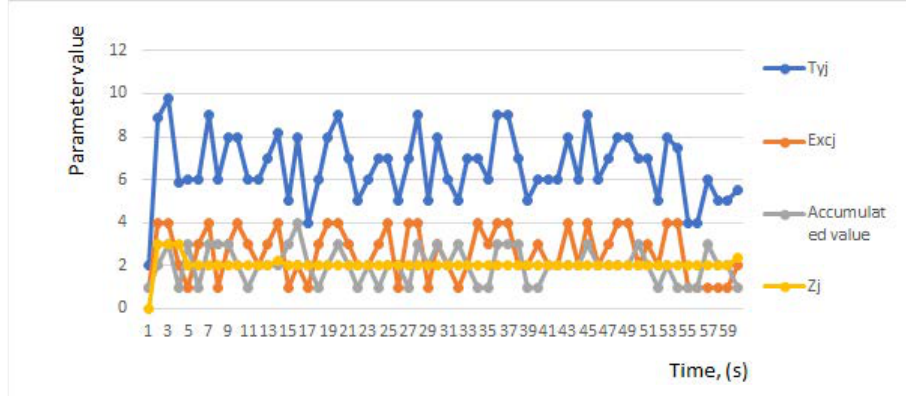
Figure 3. Illustration of the partial experimental results representing the dynamics and dependency between changing values of estimated variations of the accumulated predicted utility ( Exc j ), normalized Z j , and Ty j parameters during a short